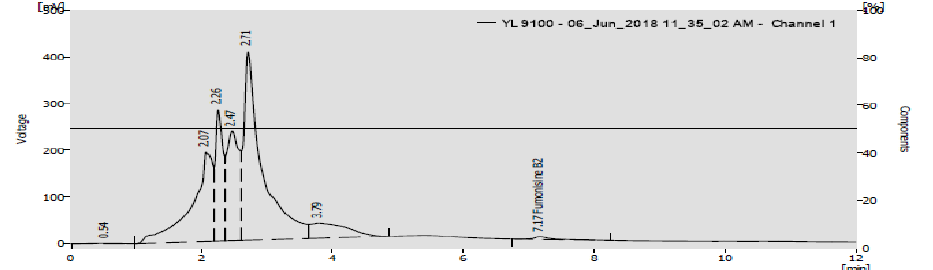
Figure, 2: HPLC chromatogram presented peak detection by absorbance at l = 220 nm and peak spectra for Fumonisin B2 (F B2) concentration in wheat seeds in ppm/ 5gm.